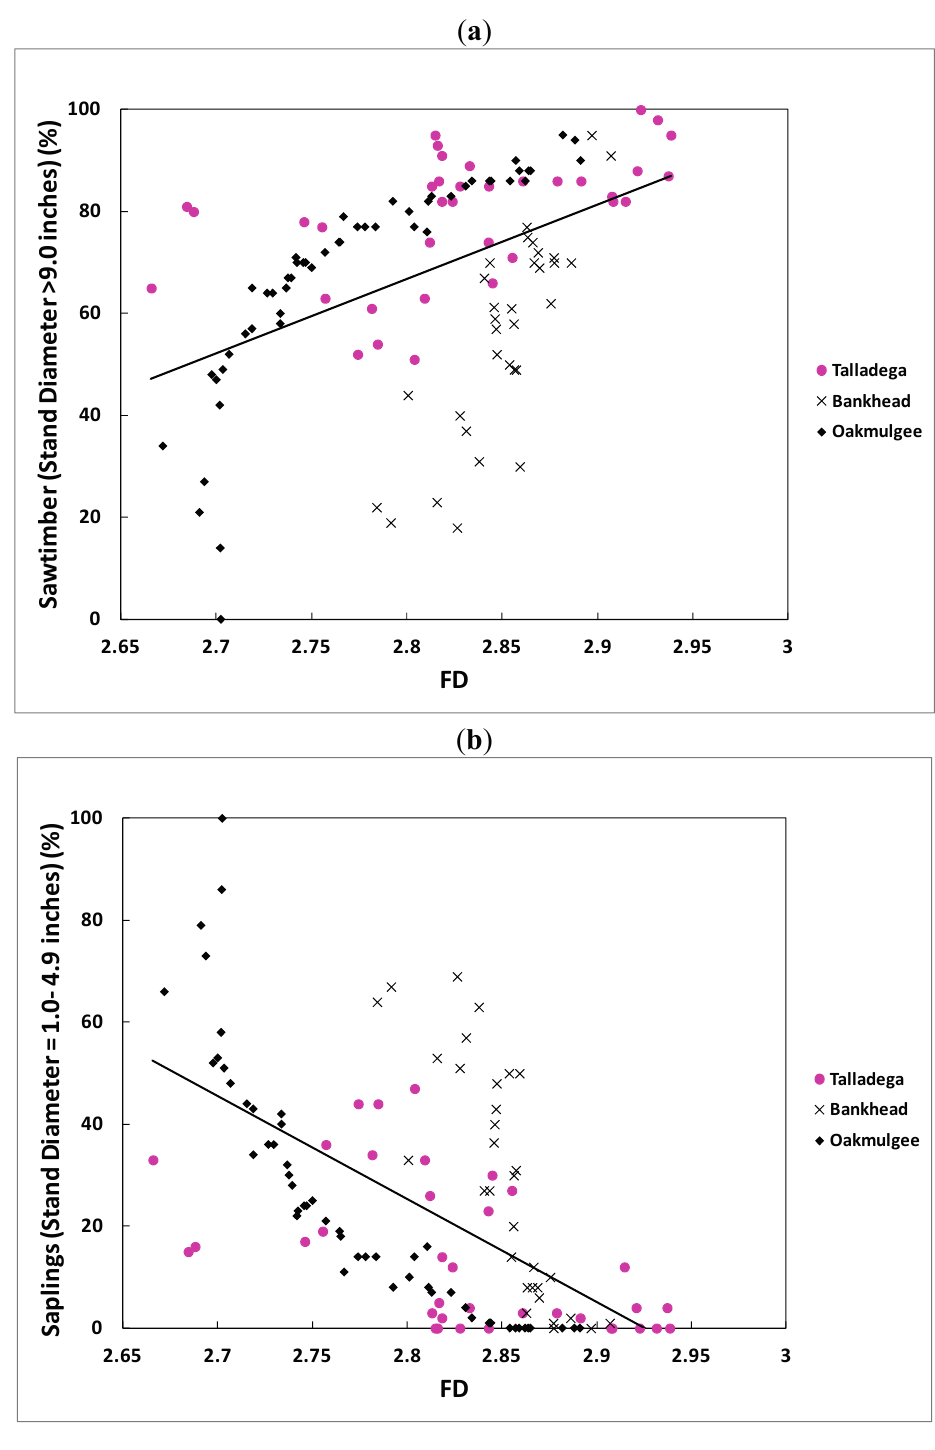
Figure 4. Linear Regression Prediction Models Using Fractal Dimension (FD): ( a ) Sawtimber, ( b )